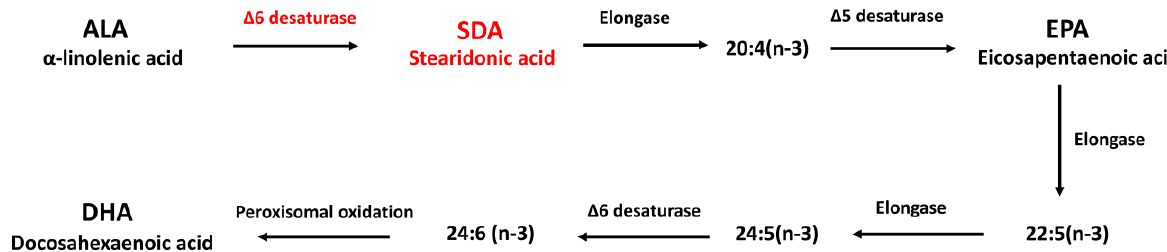
Figure 1. Metabolism of essential ω -3 fatty acids.